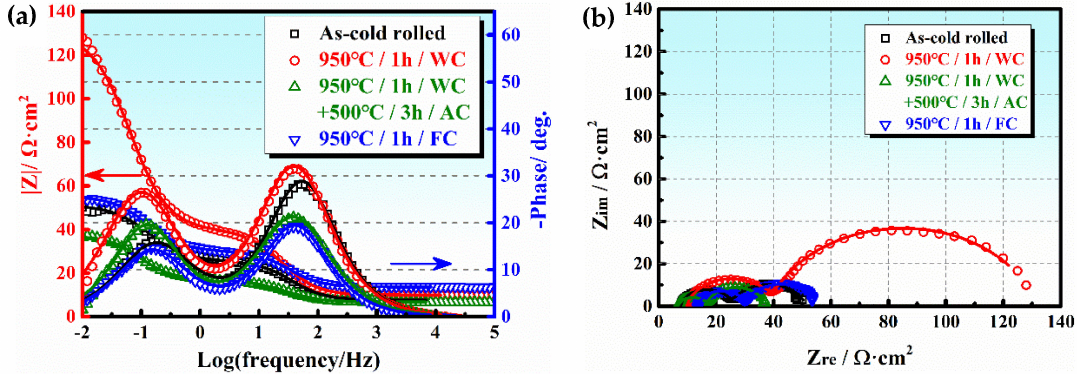
Figure 5. EIS results of as − cold rolled and heat treated sheets in naturally aerated 0.5 M H 2 SO 4 + 5 ppm F − solution: ( a ) Bode plots and ( b ) Nyquist